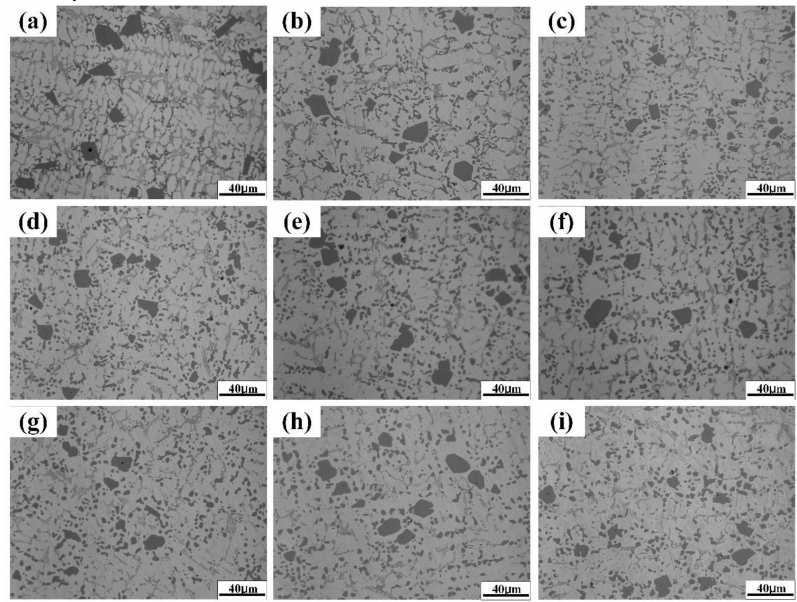
Figure 5. Microstructures of Al-13Si-5Cu-2Ni alloy 510 ◦ C solid solution treated for 8 h and 165 ◦ C aging for different hours and the size of eutectic silicon of alloys: ( a ) as cast, ( b ) 2 h, ( c ) 4 h, ( d ) 6 h, ( e ) 8 h, ( f ) 10 h, ( g ) 12 h, ( h ) 14 h, ( i ) and 16 h.